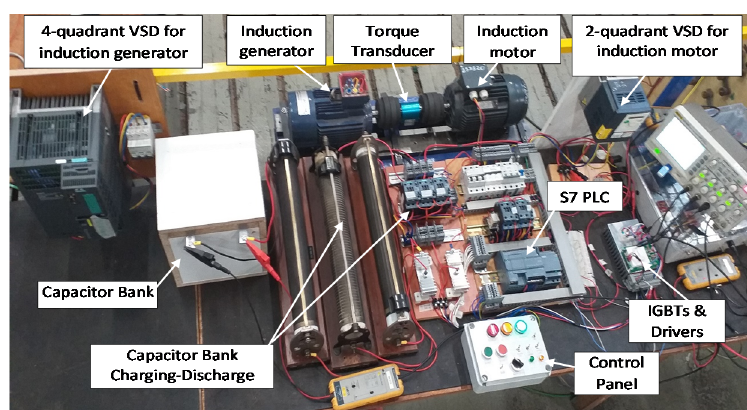
Figure 12. Laboratory experimental